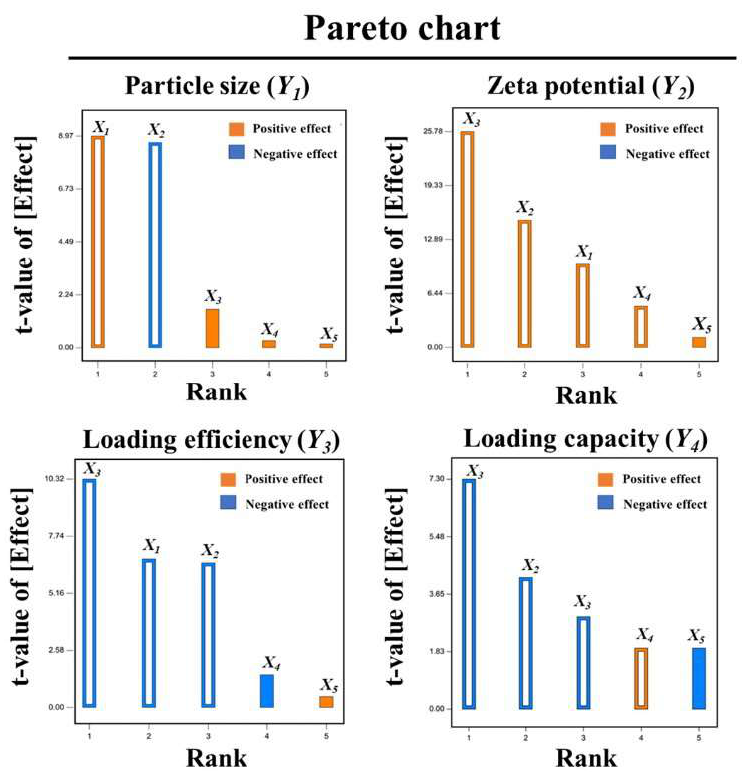
Figure 2. Plackett-Burman: Pareto charts revealing the significance of the factors on the determined responses. Significance of the given factor (X 1–5 ) on the particle size (Y 1 ), zeta potential (Y 2 ), LE (Y 3 ), and LC (Y 2 ). The blue and orange colors indicated the negative and positive effects, respectively. The transparency inside both blue and orange demonstrated the mainly significant effect at p < 0.05.